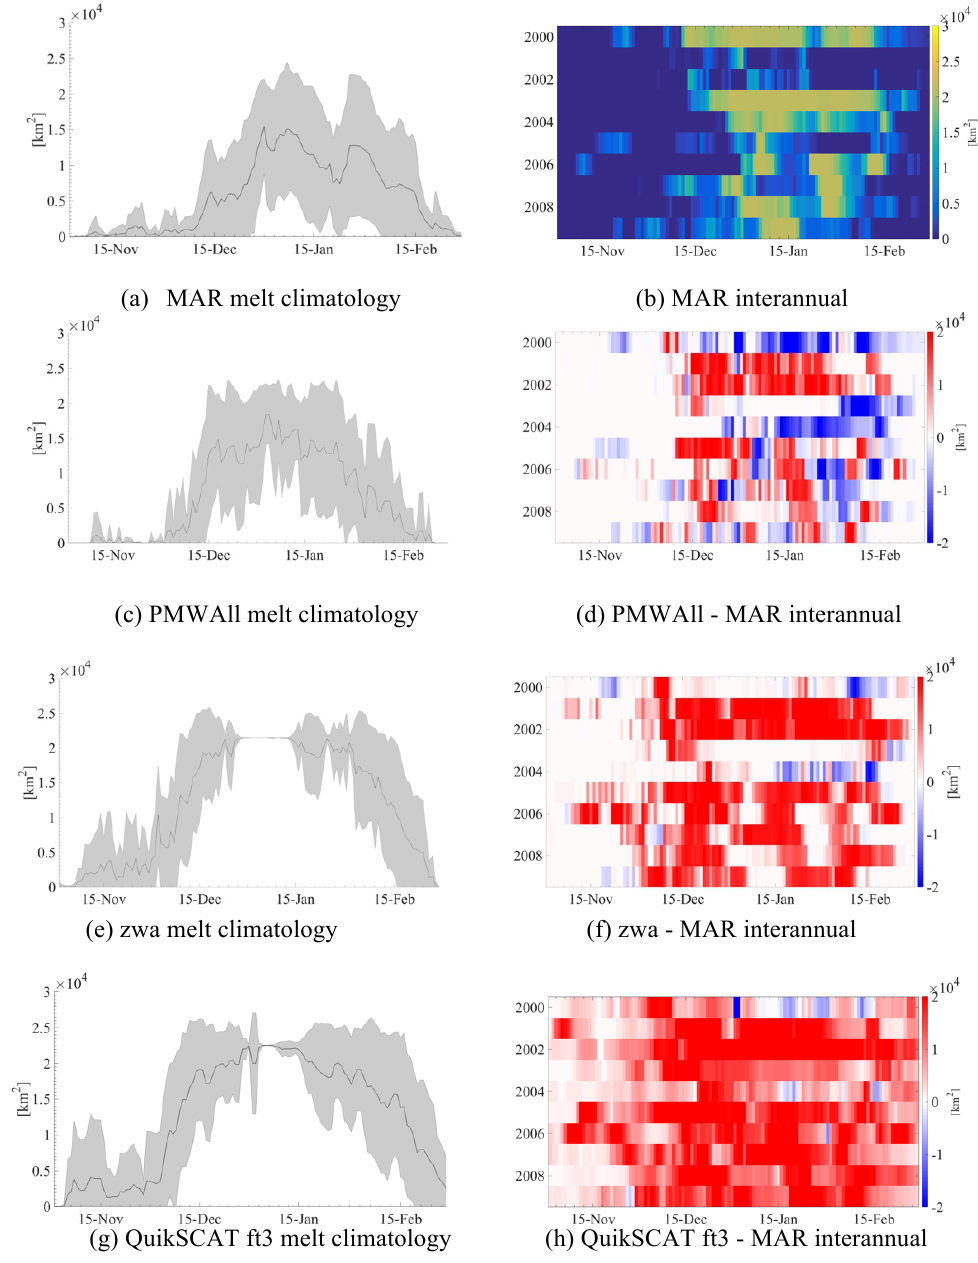
Figure 6. CL-region, described in text and shown in inset in for (a) , average and inter-annual melt occurrence in MAR, PMW, and QuikSCAT data. (a) MF0.4 melt extent climatology with one standard deviation shown in grey envelope. (b) Melt extent for MF0.4 from 1999–2009. (c) Melt climatology PMW All. (d) Interannual difference melt extent PMWAll – MAR. (e) Melt climatology PMW zwa. (f) Interannual difference in melt extent PMWzwal – MAR. (g) Melt climatology QuikSCAT ft3. (h) Interannual difference in melt extent QuikSCAT ft3 –